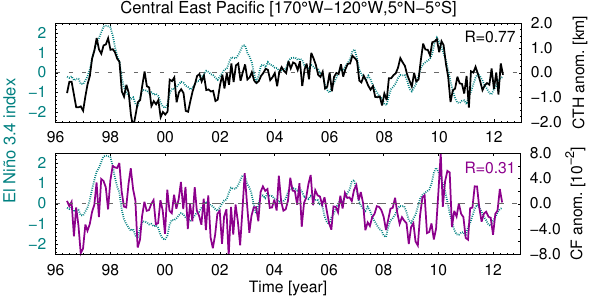
Figure 7. Time series of CTH (top) and CF (bottom) anomaly over the central East Pacific with the El Niño 3.4